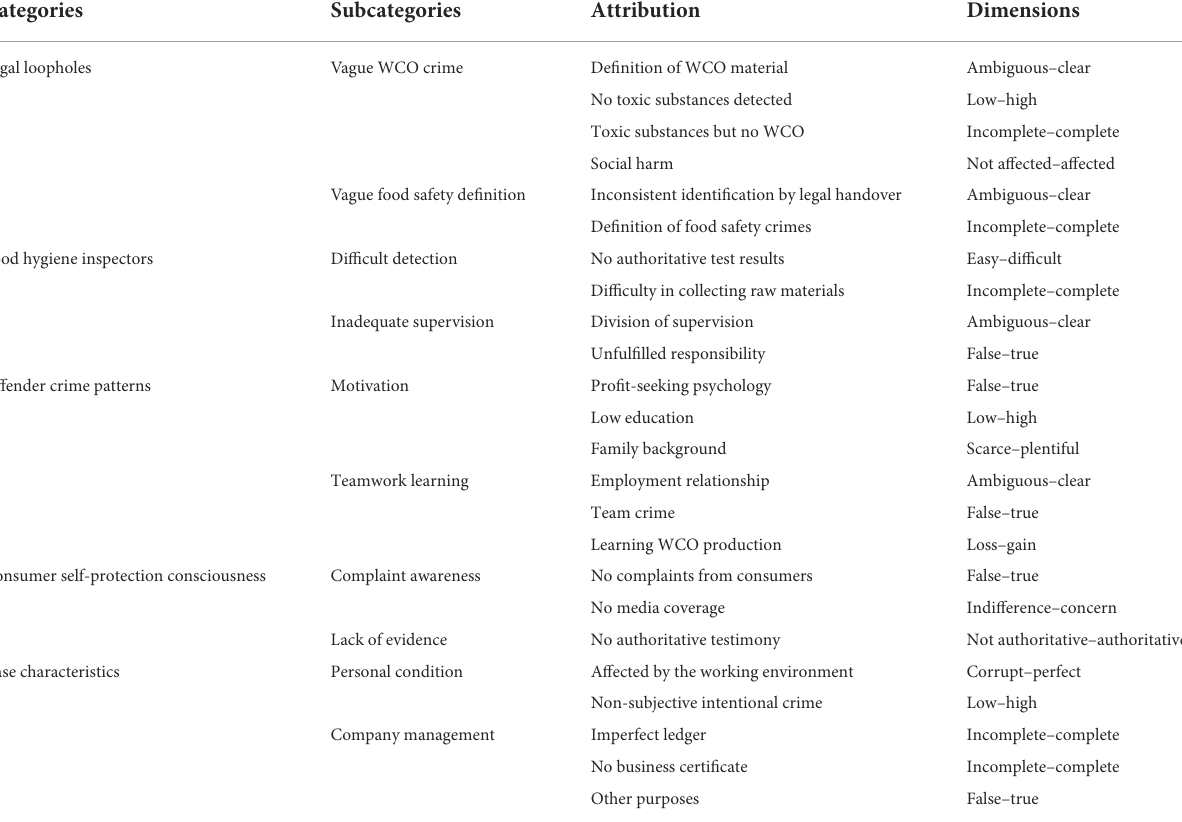
TABLE 2 Categories, subcategories, corresponding attributions, and dimensions from 152 judgments based on axial